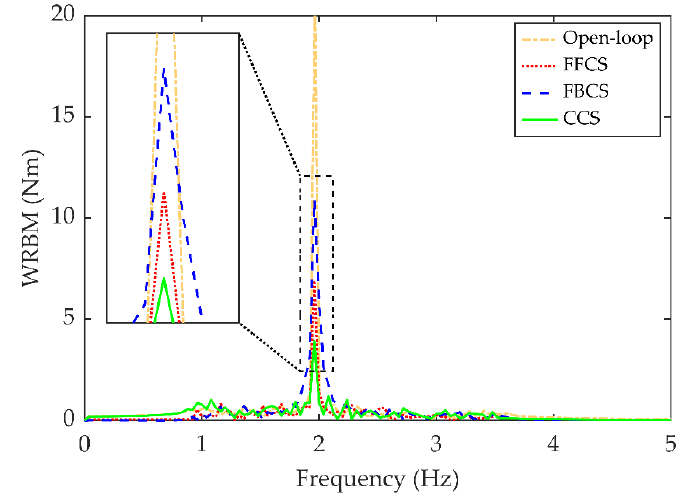
Figure 26. Frequency spectrum analysis of WRBM.